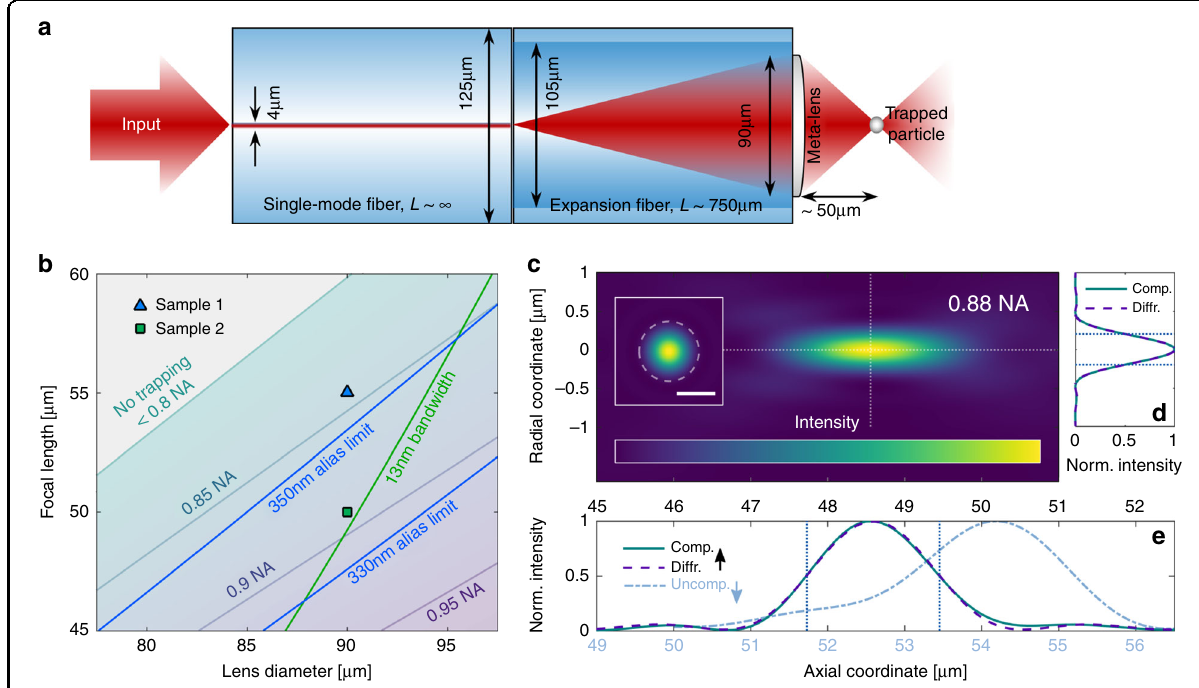
Fig. 2 Design strategy and simulated focusing performance of the on- fi bre UNM. a Detailed view of the functionalized fi bre consisting of a single-mode fi bre, spliced multimode fi bre section for beam expansion, and the meta-lens on its facet that is used to create a tight focus for trapping particles. b Meta-lens design map: Limiting factors for UNM design ( λ 0 = 660 nm). Low spatial resolution results in aliasing, while limited laser source bandwidth leads to incoherent interference of the Fresnel zones. c Simulated focal spot of an on- fi bre meta-lens including wavefront curvature correction. The inset shows the radial focal plane (scale bar: 500 nm, dashed line: with the fi tted Airy function; note that the scale of both axes is the same as that in the inset and in ( e )). The colour scale ranges linearly from zero (dark blue) to unity (yellow). d Radial and ( e ) axial (upper axis) intensity pro fi les (solid) along the symmetry axes and the corresponding fi ts (dashed). The vertical dotted lines indicate the full-width-half-maximum of the fi ts. Note that in ( e ), the uncompensated fi bre wavefront curvature (blue, lower axis) leads to a strong focal shift and spherical aberration compared to the wavefront-corrected design (green, upper